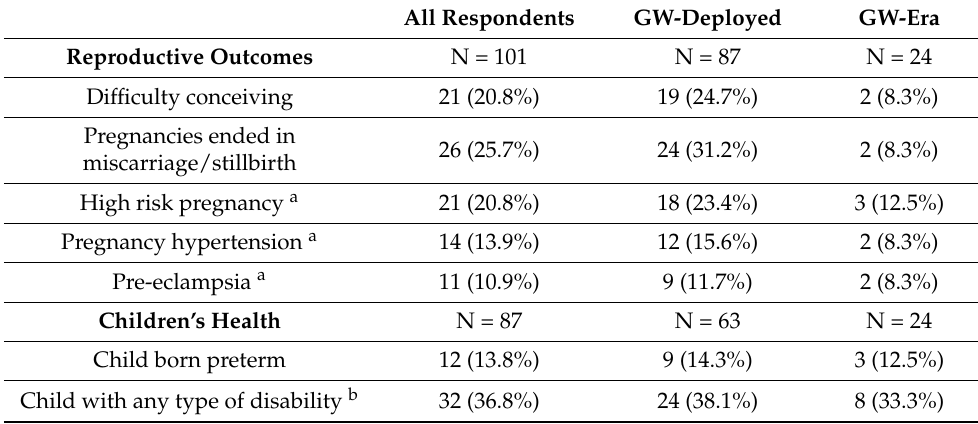
Table 2. Prevalence of reproductive outcomes, by deployment